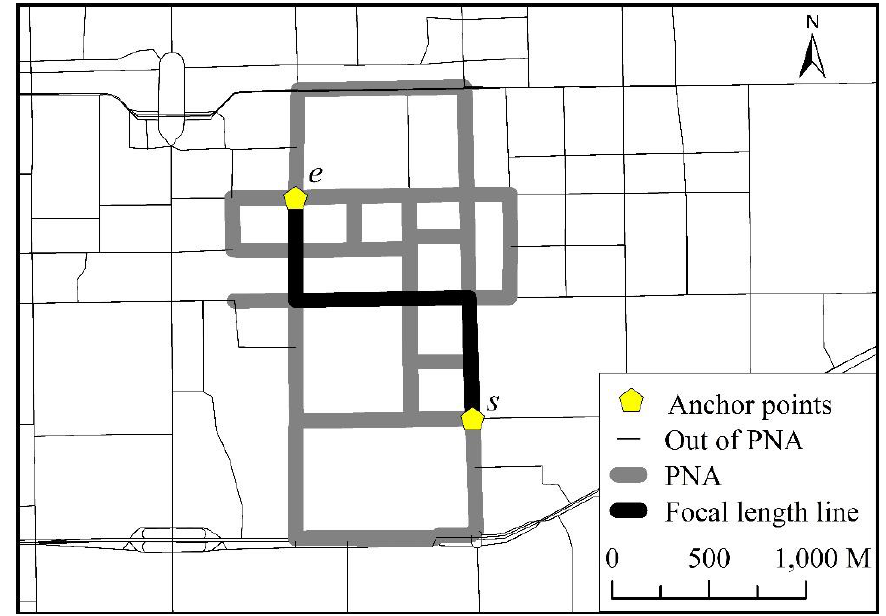
Figure 8. A PNA constructed by a pair of anchor